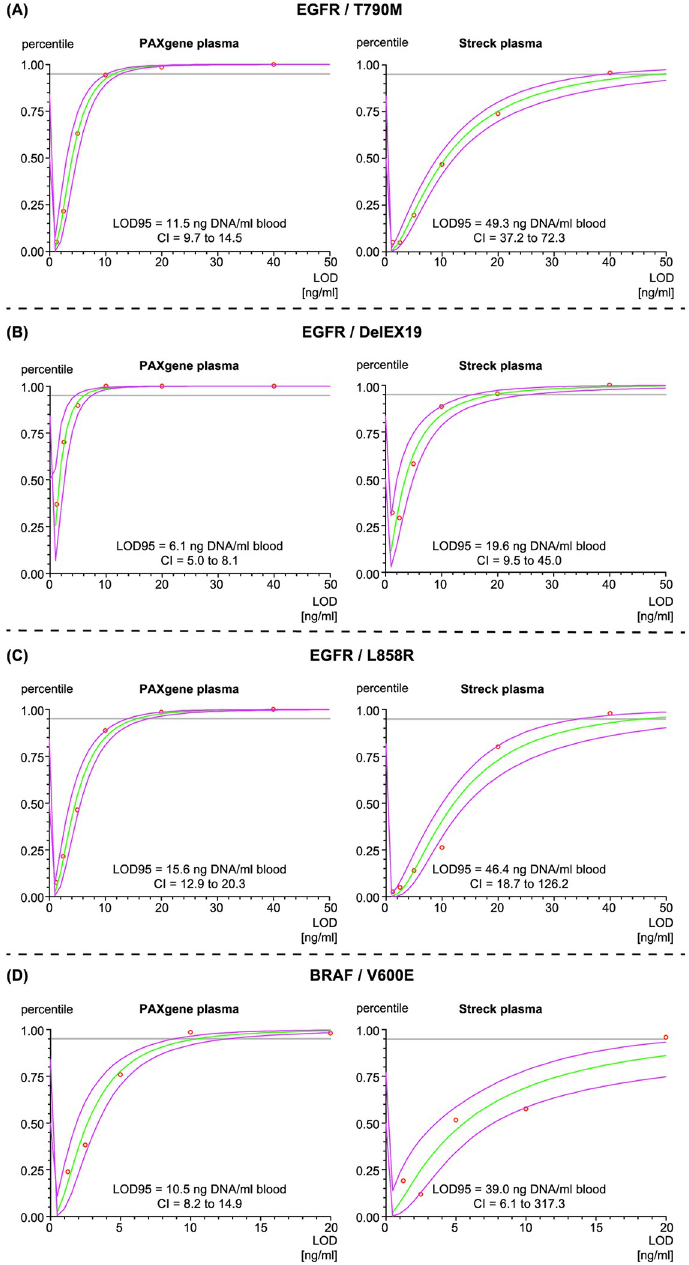
Fig 3. Detection rates and confidence intervals. Calculations and graphs were executed by probit-model-based Arcus Quickstat Statistical Software Version 1.1.0.137. Green lines represent the calculated LOD and purple lines represent the corresponding confidence intervals. CI stands for confidence